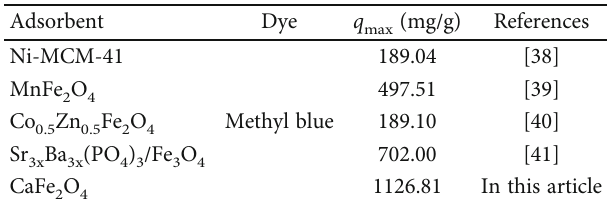
Table 3: Comparison of the maximum adsorption capacity of di ff erent